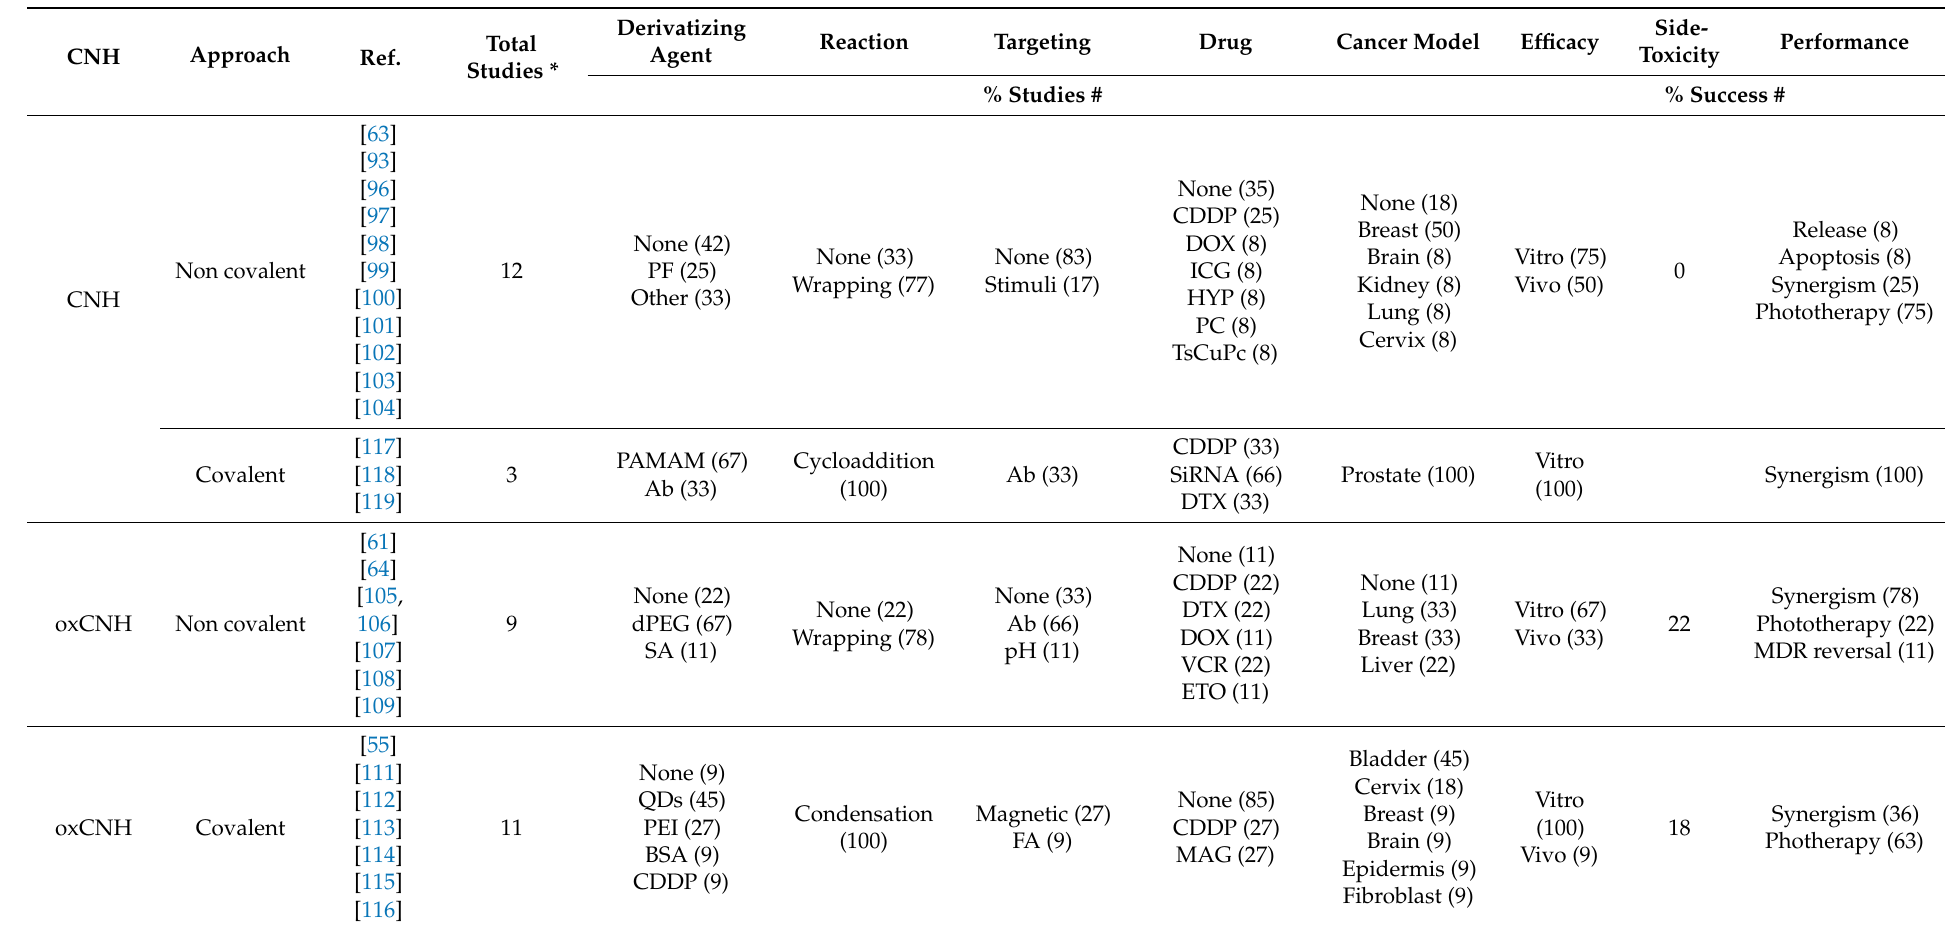
Table 3. Main outcome of the studies covered in this